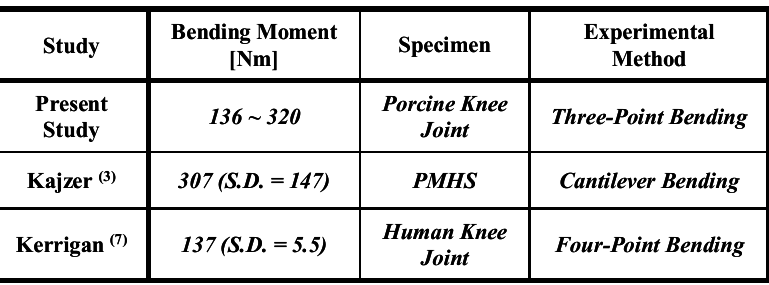
Table 3 Injury criteria for knee joint obtained in present study and previous studies.